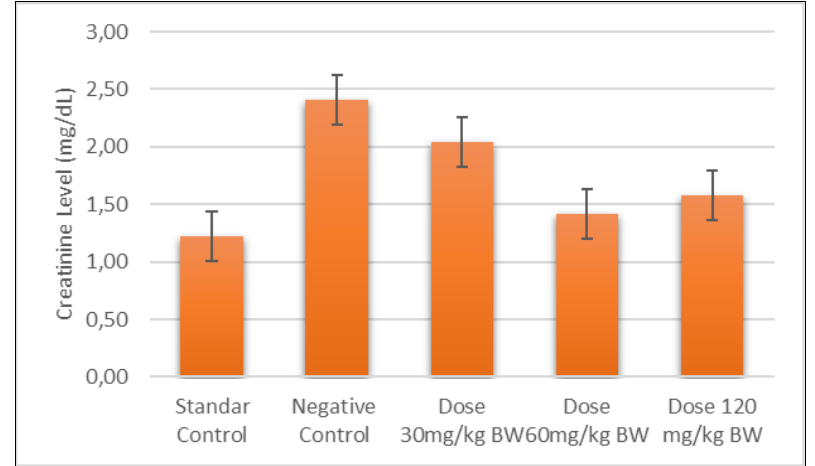
Figure 1: The Creatinine Levels.